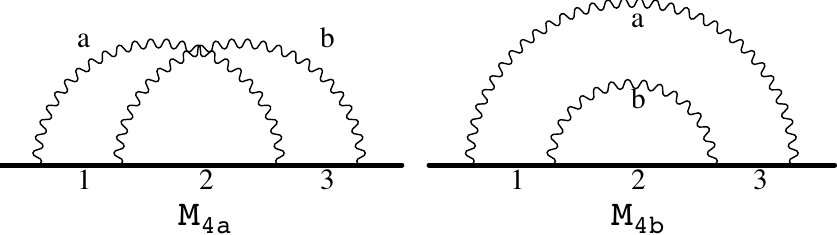
Figure 6. Fourth-order self-energy-like diagrams, M 4 a and M 4 b . The solid and wavy lines represent electron and photon propagators,